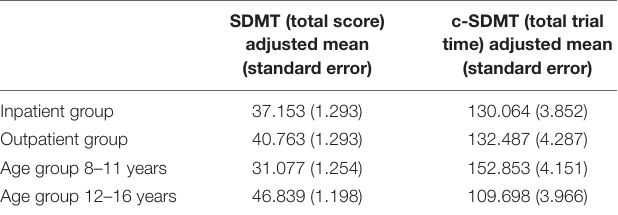
TABLE 3 | Descriptive statistics of c-SDMT and SDMT by group, adjusted for